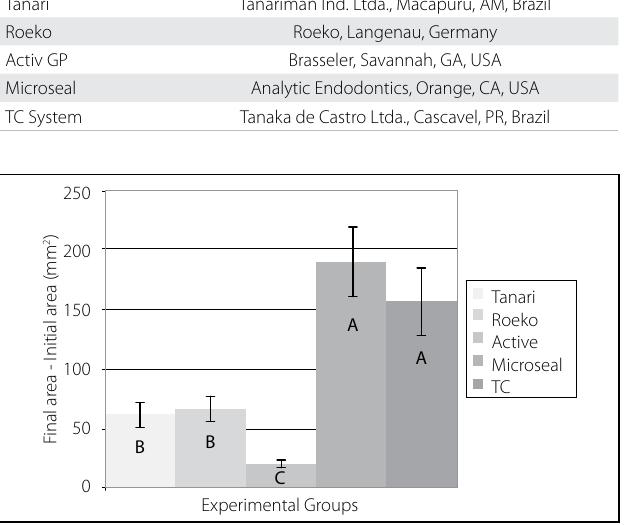
Figure 1. Means ( ± sd) in mm 2 of the differences between final and initial areas for each filling material. Means with the same letter did not differ significantly from each other (p >